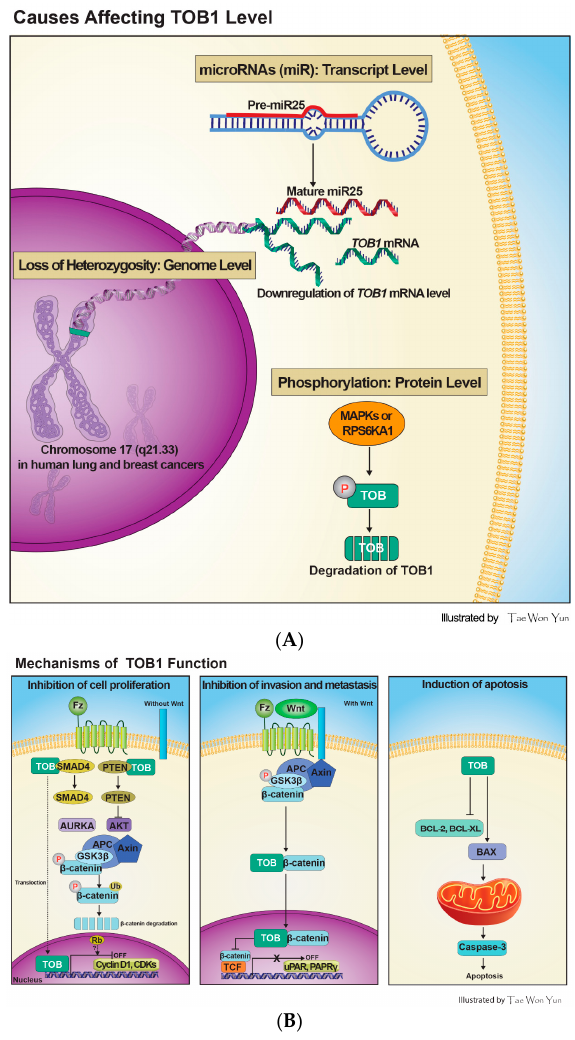
Figure 2. Processes affecting TOB1 levels and diverse mechanisms underlying TOB1 tumor suppression activity. ( A ) The level of TOB1 expression is affected by three different mechanisms, including LOH for TOB1 gene in the cancer genome, down-regulation of TOB1 mRNA expression by target microRNAs, and induction of TOB1 protein degradation by cues such as its phosphorylation. miR25 represses TOB1 mRNA expression by binding to its 3 ′ -untranslated region (3 ′ -UTR) directly. TOB1 phosphorylated by MAPKs or RPS6KA undergoes ubiquitination by the ubiquitin ligase, SKP2, resulting in its degradation through the proteasomal pathway; ( B ) TOB1, a tumor suppressor protein, inhibits cancer cell proliferation, invasion, and metastasis and leads to the induction of apoptosis. In addition to inhibiting the transcription of cell cycle-associated genes in the nucleus, TOB1 physically cooperates with tumor suppressors, SMAD4 or phosphatase, and tensin homolog-10 (PTEN), to produce a yet unknown signal for the degradation of AURKA or AKT, thereby indirectly regulating β -catenin level in the cytosol. Moreover, TOB1 directly interacts with β -catenin in the nucleus, leading to down-regulation of target genes of the TCF/ β -catenin complex. TOB1 overexpression induces the reduction of BCL-2 and BCL-XL expression, increment of BAX expression, and caspase-3 activation.